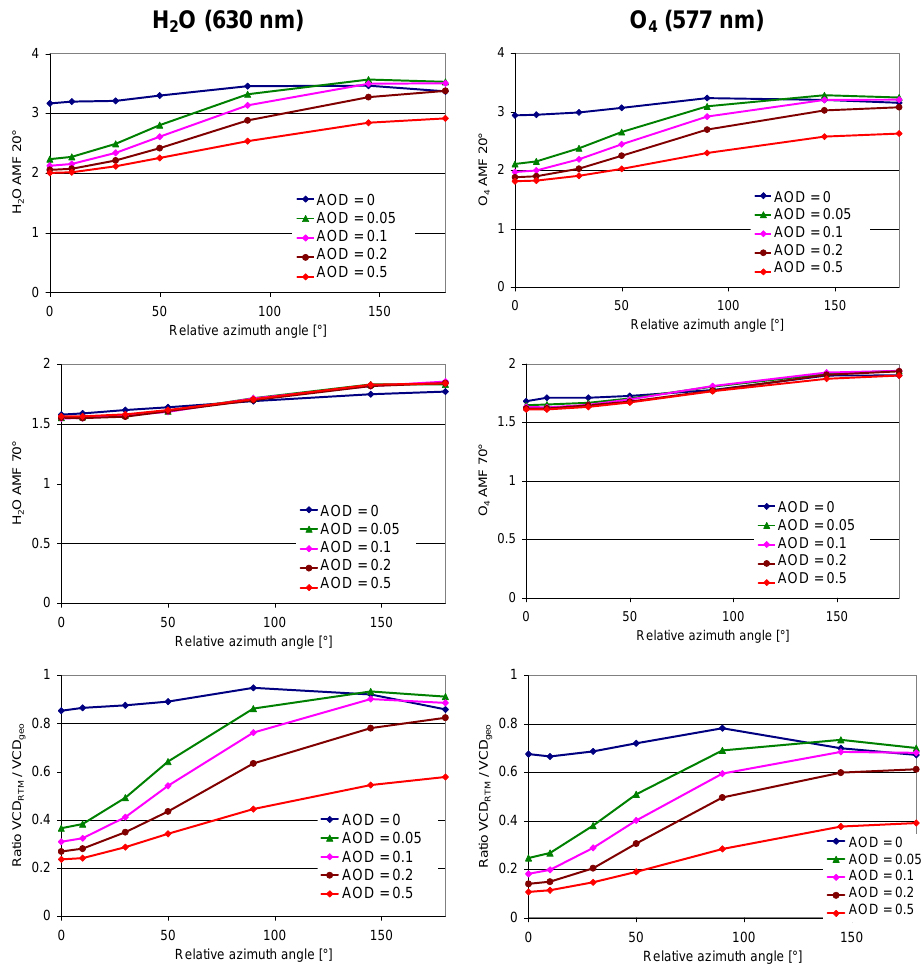
Fig. 4. Results of radiative transfer simulations for H 2 O (scale height of 2km, left) and O 4 (scale height of 4km, right) for different aerosol loads. Top: AMFs for an elevation angle of 20° as function of the RAZI. Middle: AMFs for an elevation angle of 70° as function of the RAZI. Bottom: Ratio of simulated AMF-differences (20° minus 70°) and those using the geometric approximation. This ratio describes the underestimation of the true VCDs by retrievals based on the geometric approximation. The aerosol layer was assumed to have constant extinction between the surface and 1km. The solar zenith angle is 50°.